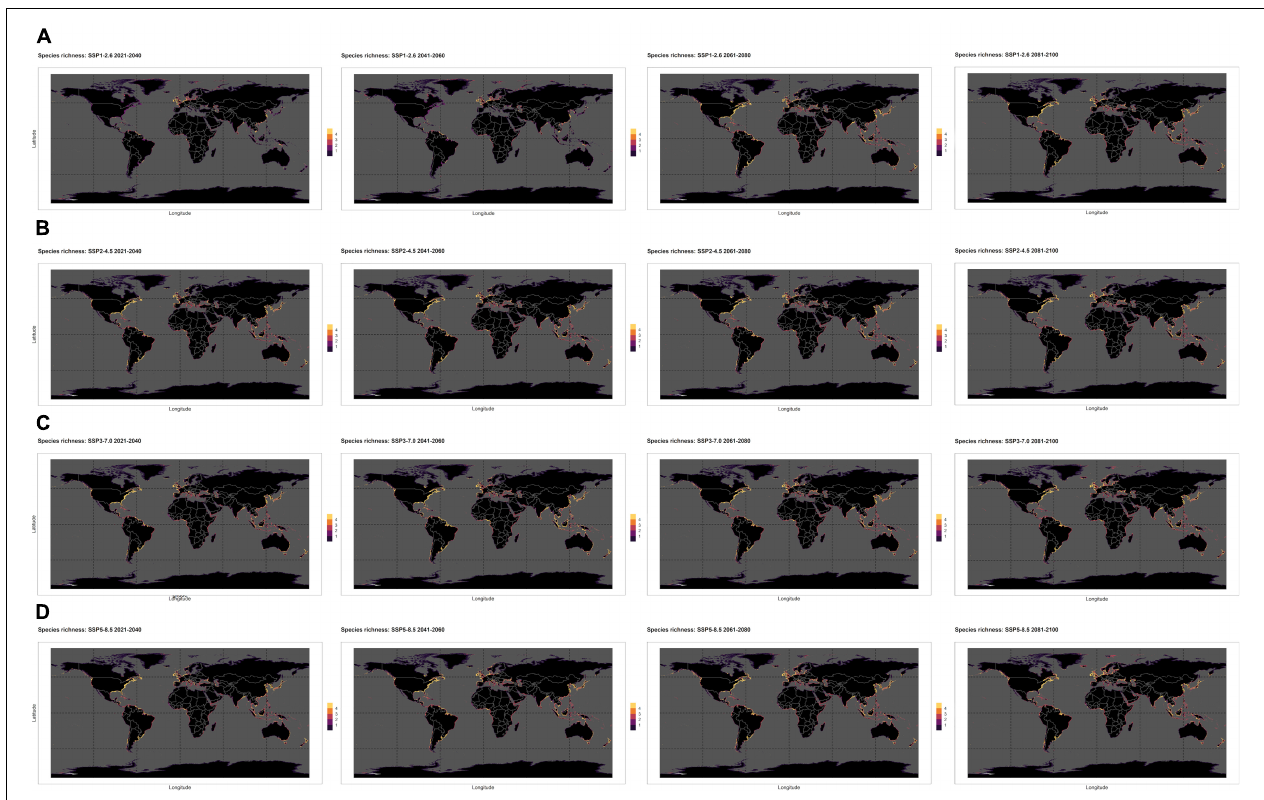
FIGURE 7 | Worldwide distribution of species richness over time (until 2100) of Spartina spp. species (i.e., S. alterniflora , S. anglica , S. densiflora , S. maritima , and S. patens ) for each CMIP6 Shared Socioeconomic pathway, SSP1-2.6, (A) , 2-4.5 (B) , 3-7.0 (C) , and 5-8.5 (D)